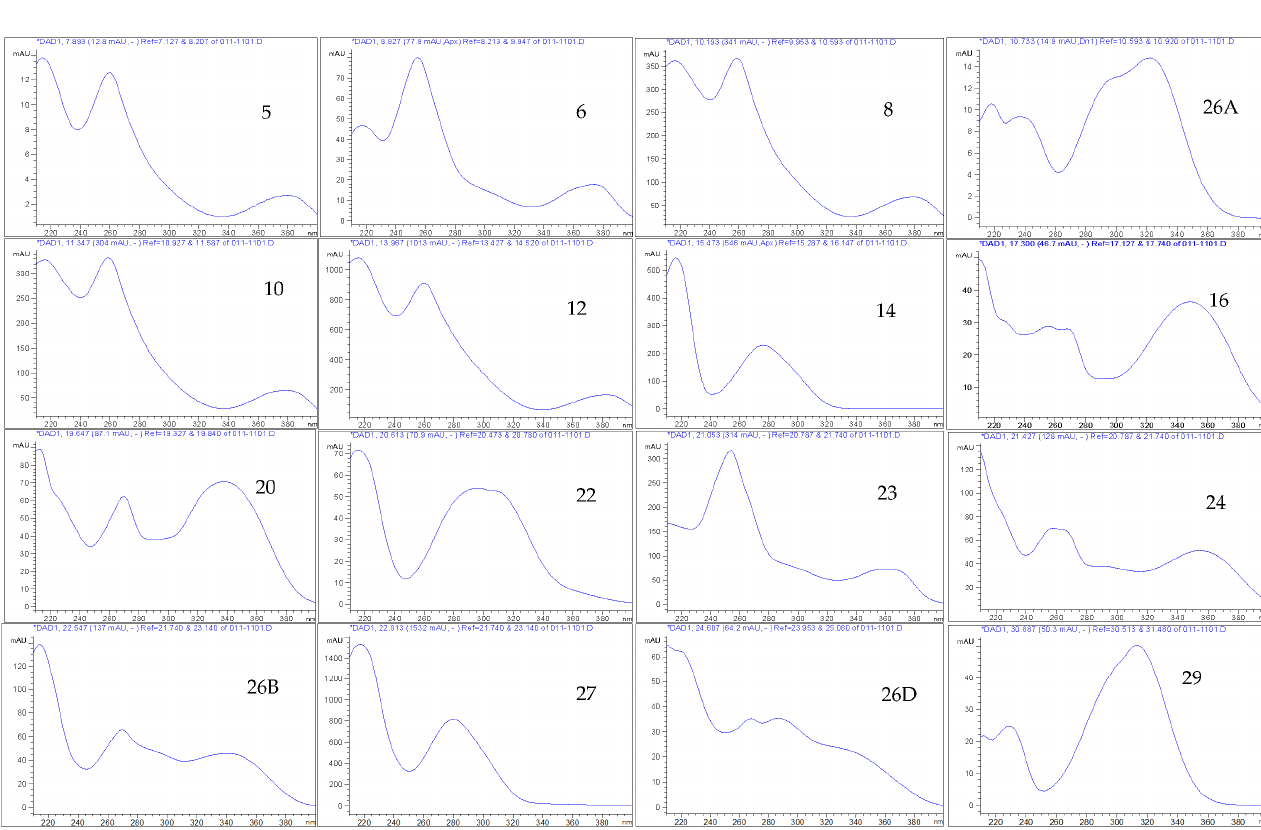
Figure 4. UV λ absorption maxima spectra obtained from HPLC-DAD at 270 nm for the detected compounds in Terminalia brownii leaf ethyl acetate extract. The used solvent for dissolving this extract is methanol to water 50%:50% ( v / v ). mAU (milli-Absorbance Units) in y-axis is a measure of the intensity of absorbance at various waveengths. Numbering of compound spectra according to the numbers in Figure 3.